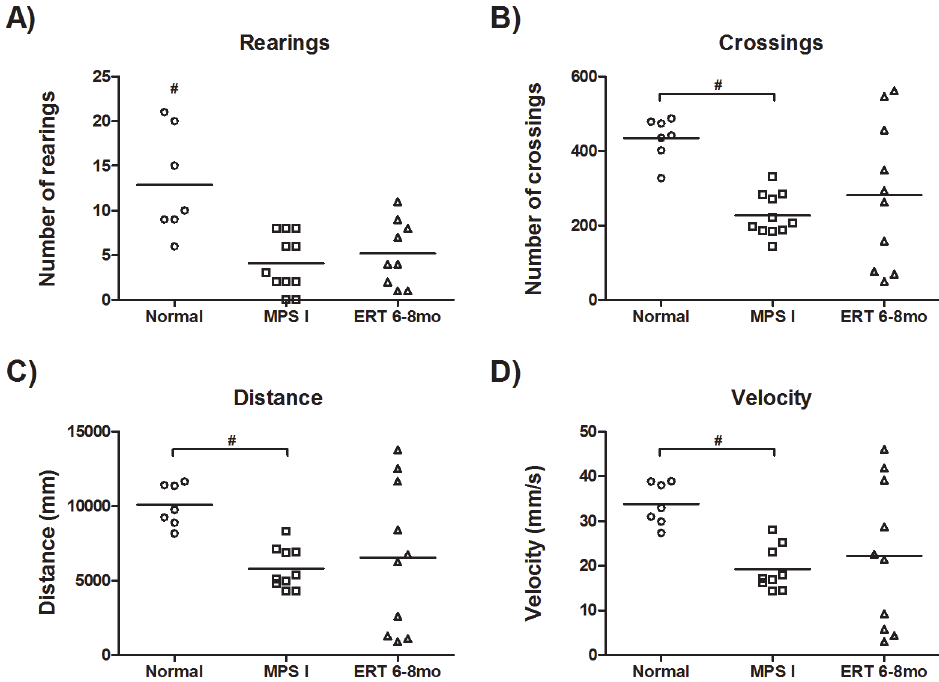
Fig 4. Open field test. Results from 8-month old normal (n = 7), MPS I (n = 11) and 6 to 8 months laronidase treated MPS I (ERT 6 – 8mo, n = 10), 2 weeks after last injection. #P (cid:1) 0.04, Kruskal-Wallis and Mann-Whitney post hoc .